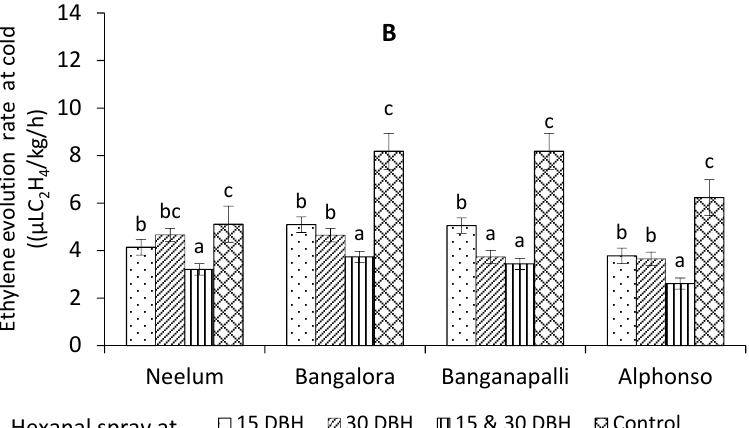
Figure 5. Mean ethylene evolution rate of the hexanal-treated and control mango fruit cultivars during the storage period in ambient ( A ) and cold ( B ) storage condition. The vertical bars in the columns represent the standard error of four replicates (n = 15). Columns with different and the same letters indicate statistical significance and non-significance, respectively ( p = 0.05). DBH—Days before harvest.